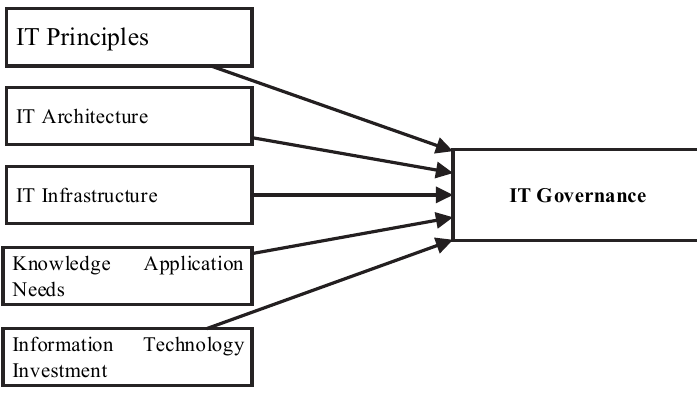
Fig. 2 . Information Technology Governance